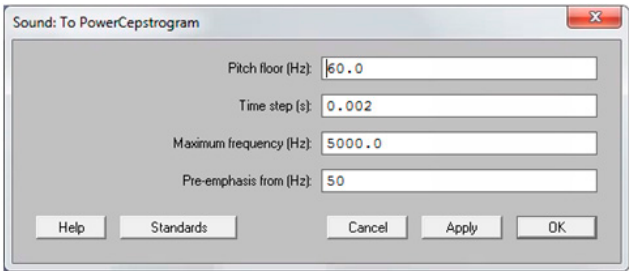
Figure 1. Printscreen with the arguments for the parameters to retrieve the powercepstrogram in the software Praat, for Windows computers (identical settings are used for Mac computers).